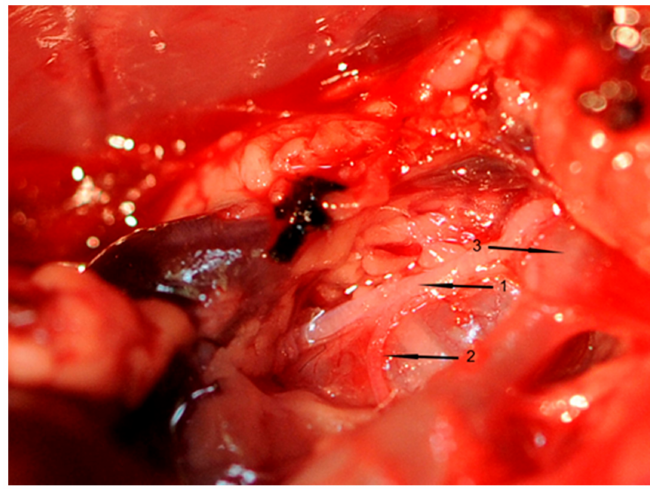
Figure 7. Representative figure of right cardiac vagus nerve preparation. 1 = Nervus vagus dexter, 2 = Cardiac branch of the right vagus nerve, 3 = Truncus brachiocephalicus. A respective sham operation was performed in rats of groups I and III without cutting the